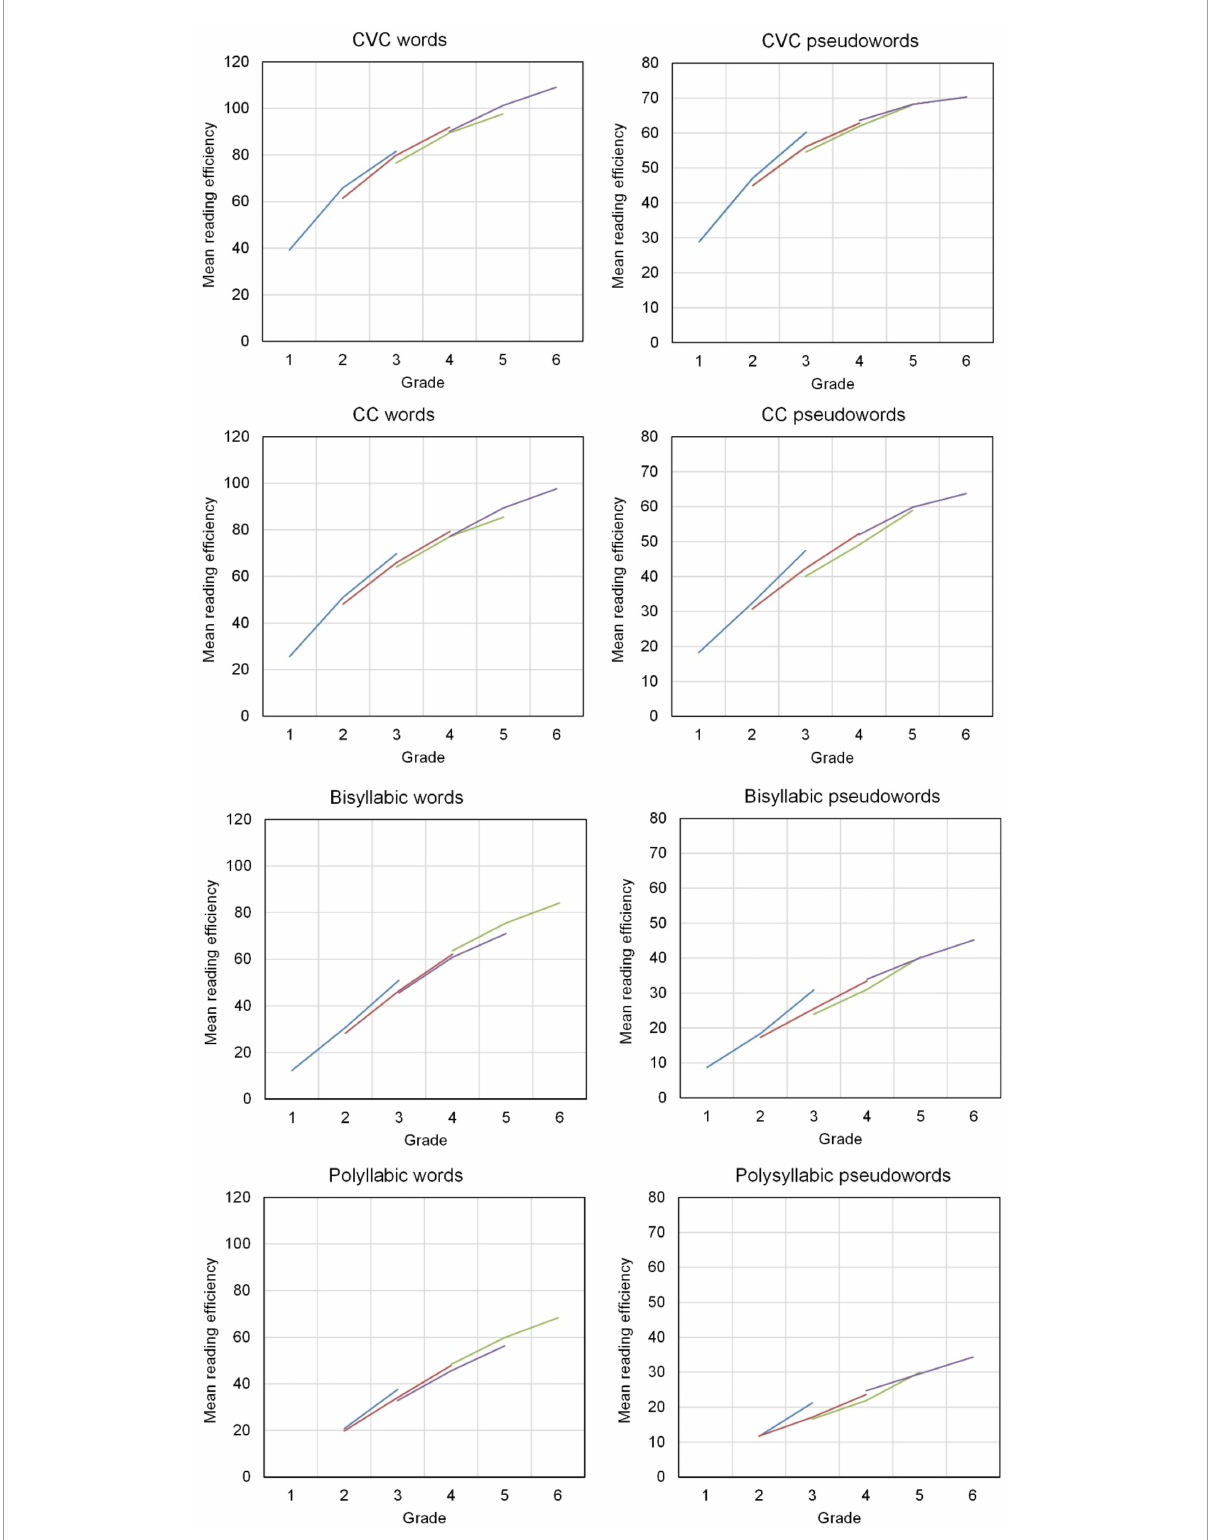
FIGURE2 Average development of word decoding efficiency (number of words correctly read in 1 min) across Grade 1 thru 6 (blue line: Cohort 1, red line: Cohort 2, green line: Cohort 3, purple line: Cohort